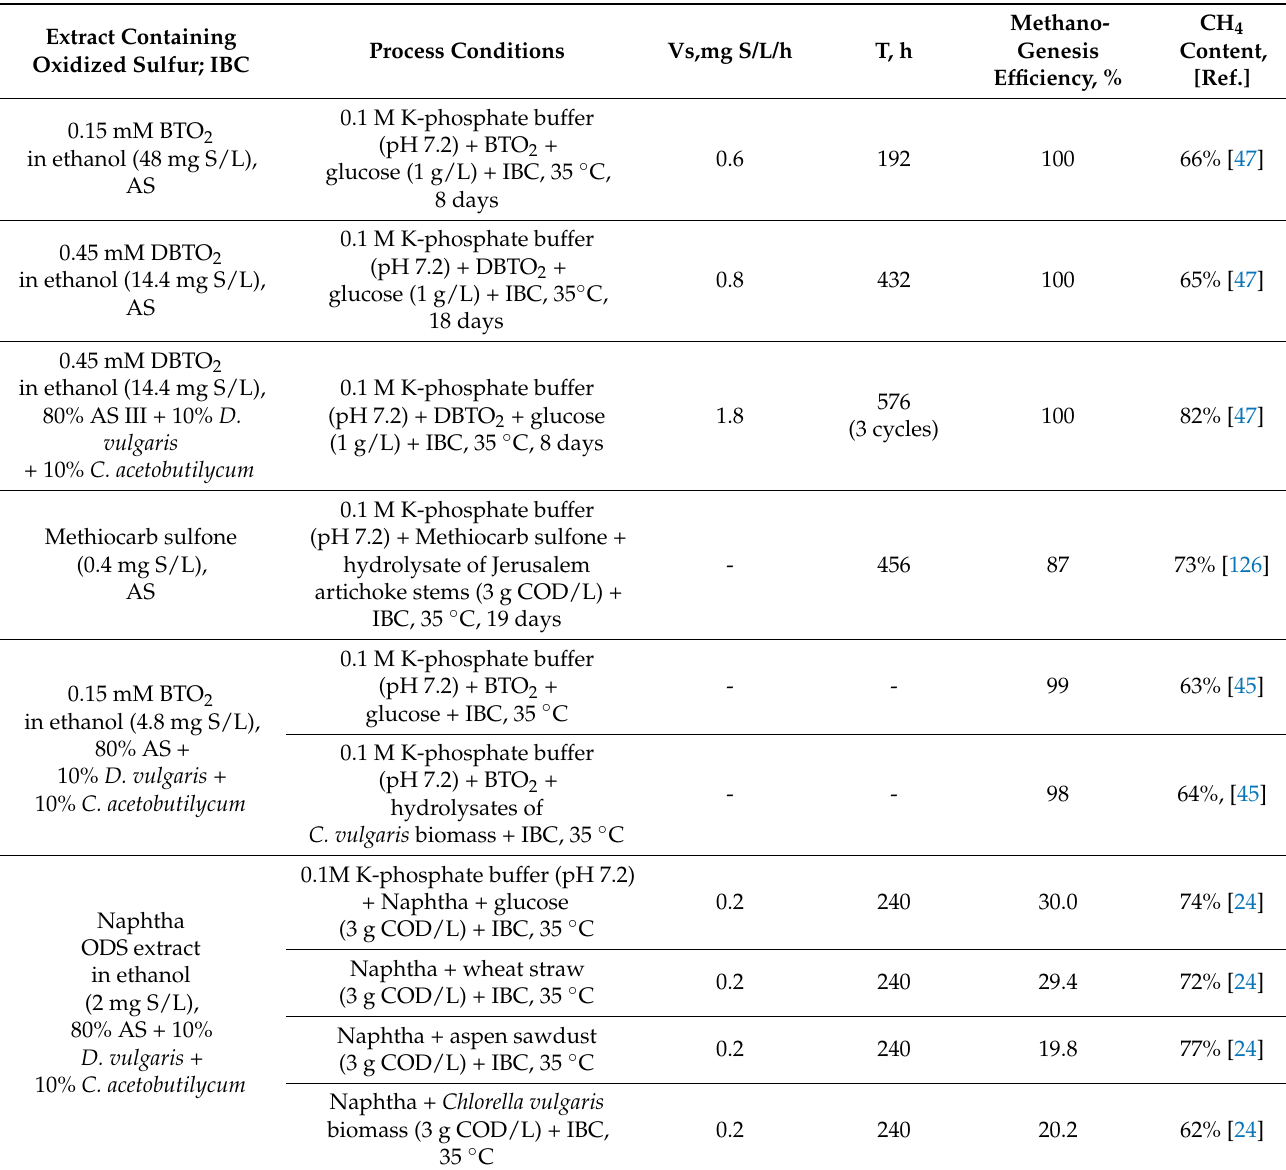
Table 5. Application of IBCs in the form of cells immobilized in PVA cryogel in the processes of reductive biotransformation of oxidized forms of organic compounds. Process Conditions Vs,mg S/L/h T, h